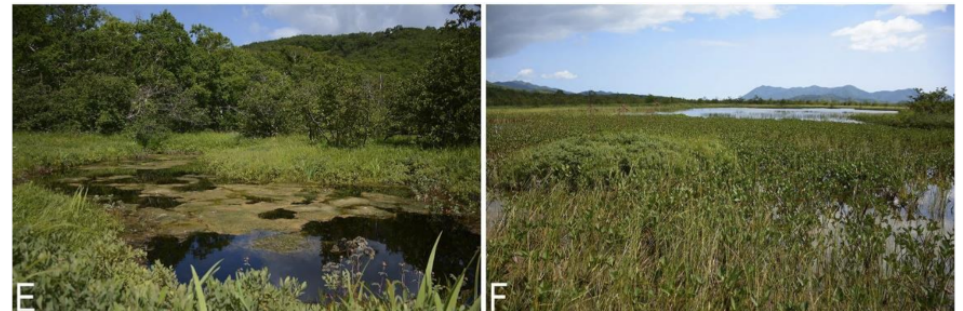
Figure 3. ( A ) view of the Pravaya Khodutka River valley from Priyomysh Volcano (975 m a.s.l.), Alnus fruticosa thickets belt with rare Pinus pumila clumps are in the foreground, Betula ermanii forest is dominating in river valley in the background, grass land in the bottom; ( B ) view of the Khodutkinskie Hot Springs from Priyomysh Volcano (975 m a.s.l.), thermal fields near the river surrounded by Betula ermanii forest, open places are occupied by tall herbs ( Filipendula camtschatica, Senecio cannabifolius, Heracleum lanatum ); ( C ) Khodutkinskie Hot Springs area, Equisetum fluviatile community is in the foreground; ( D ) swampy Salix thickets in foreground, changed for Alnus fruticosa and then for Betula ermanii , lower course of Asacha River, 13 m a.s.l.; ( E ) the pond in swampy massif, surrounded by Betula platyphylla , Myrica tomentosa is in the foreground, lower course of Asacha River, 13 m a.s.l.; ( F ) rich fen with Menyanthes trifoliata dominating, lower course of Asacha River (Photo by K.G. Klimova, 2021).